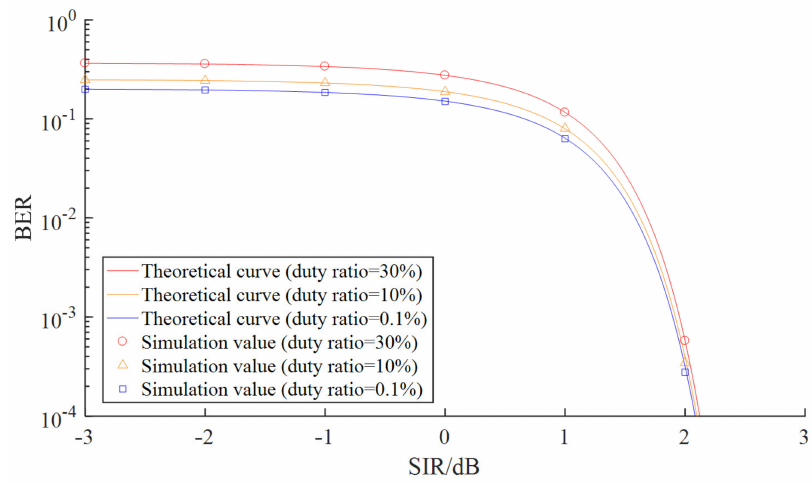
Figure 11. Variation curve of receiver BER with SIR under pulse signal interference (logarithmic form).